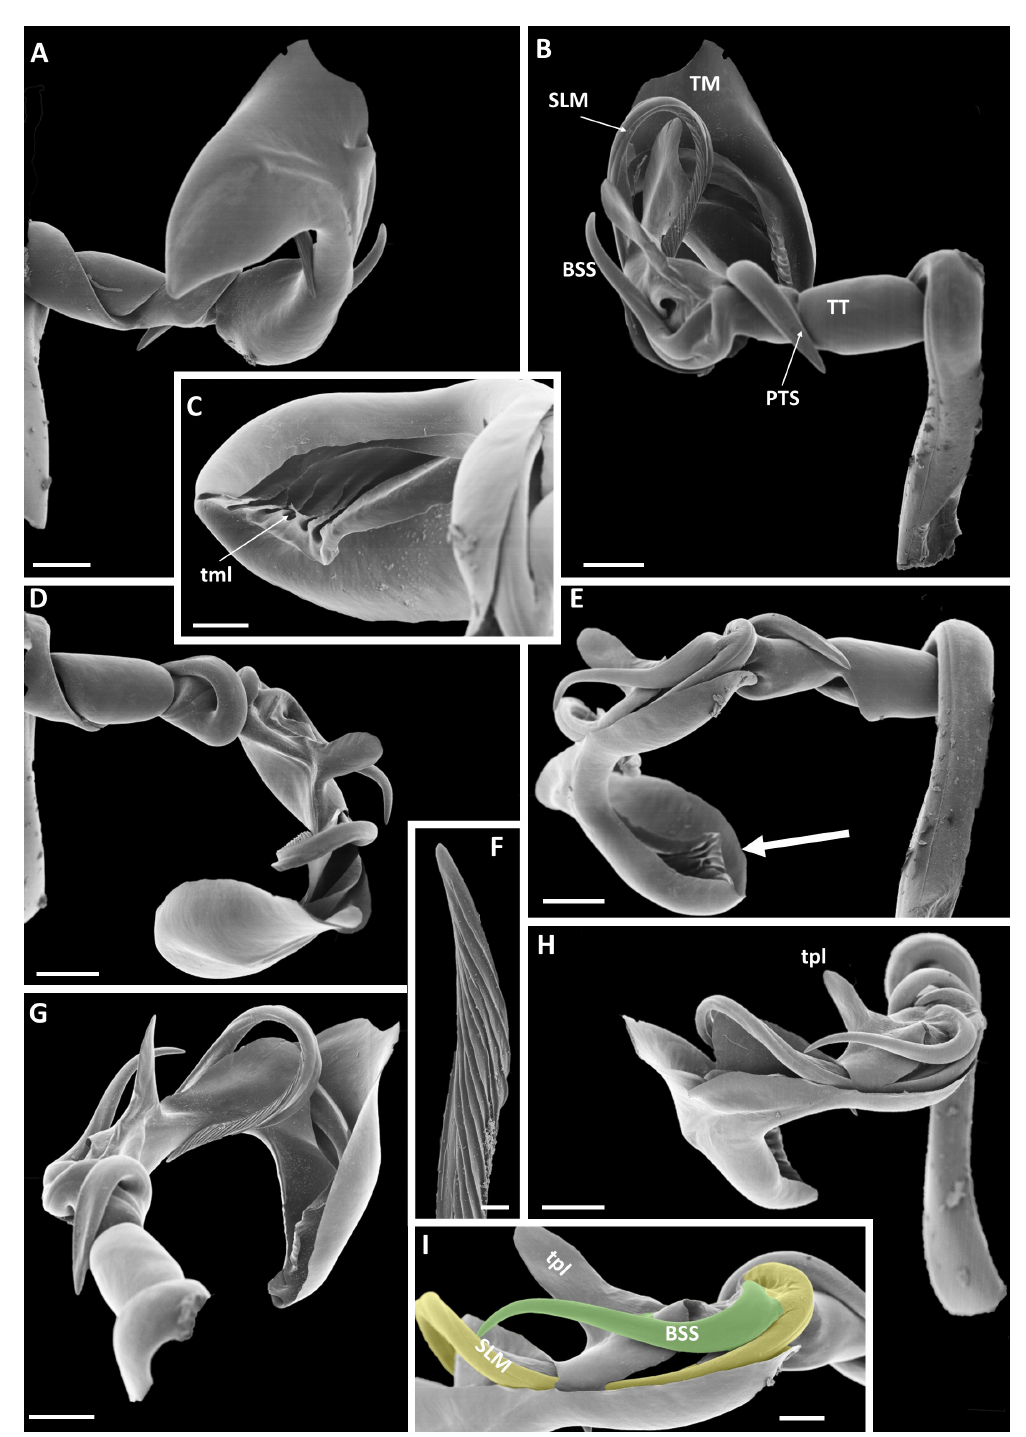
Fig. 51. Praludivera paralellamella gen. et sp. nov., holotype, ♂ (VMNH110633), left gonopod telopodite. A . Anterior view. B . Posterior view. C . Detail of part of interior surface of telomere (area indicated with large arrow in E). D . Ventral view. E . Dorsal view. F . Tip of solenomere. G . Sublateral- dorsal view. H . Submesal view. I . Basal part of telomere with solenomere (highlighted in yellow) and basal solenomeral spine (highlighted in green). Abbreviations: BSS = basal solenomeral spine; PTS = post- torsal spine; SLM = solenomere; TM = telomere; tpl = telomeral perpendicular lobe; TT = torsotope. Scale bars: A–B, D–E, G–H = 0.2 mm; C, I = 0.1 mm; F = 0.02